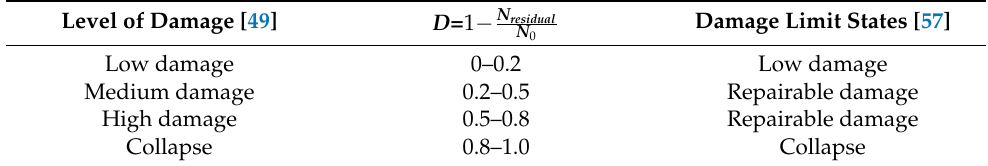
Table 5. Damage levels of RC column in terms of axial load